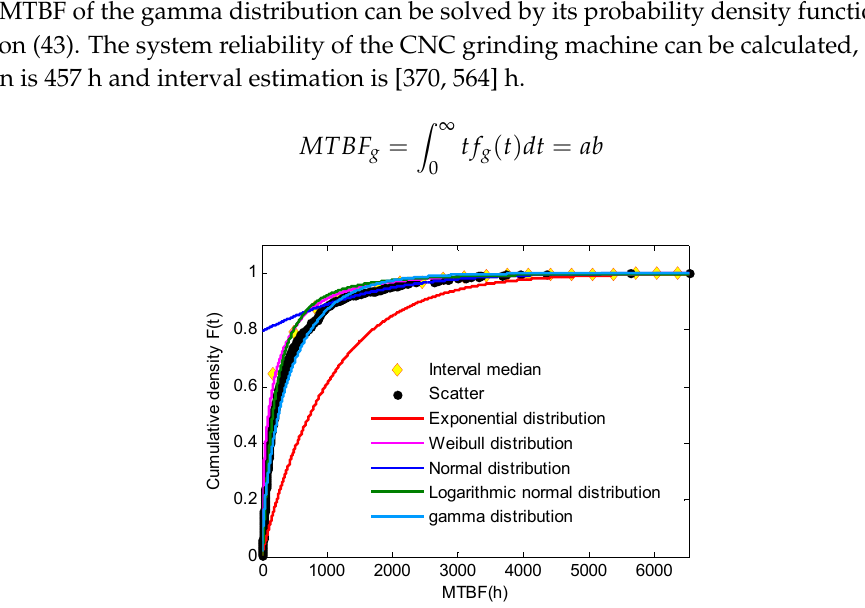
Figure5. Cumulative distribution curve of time between failures of whole machine.